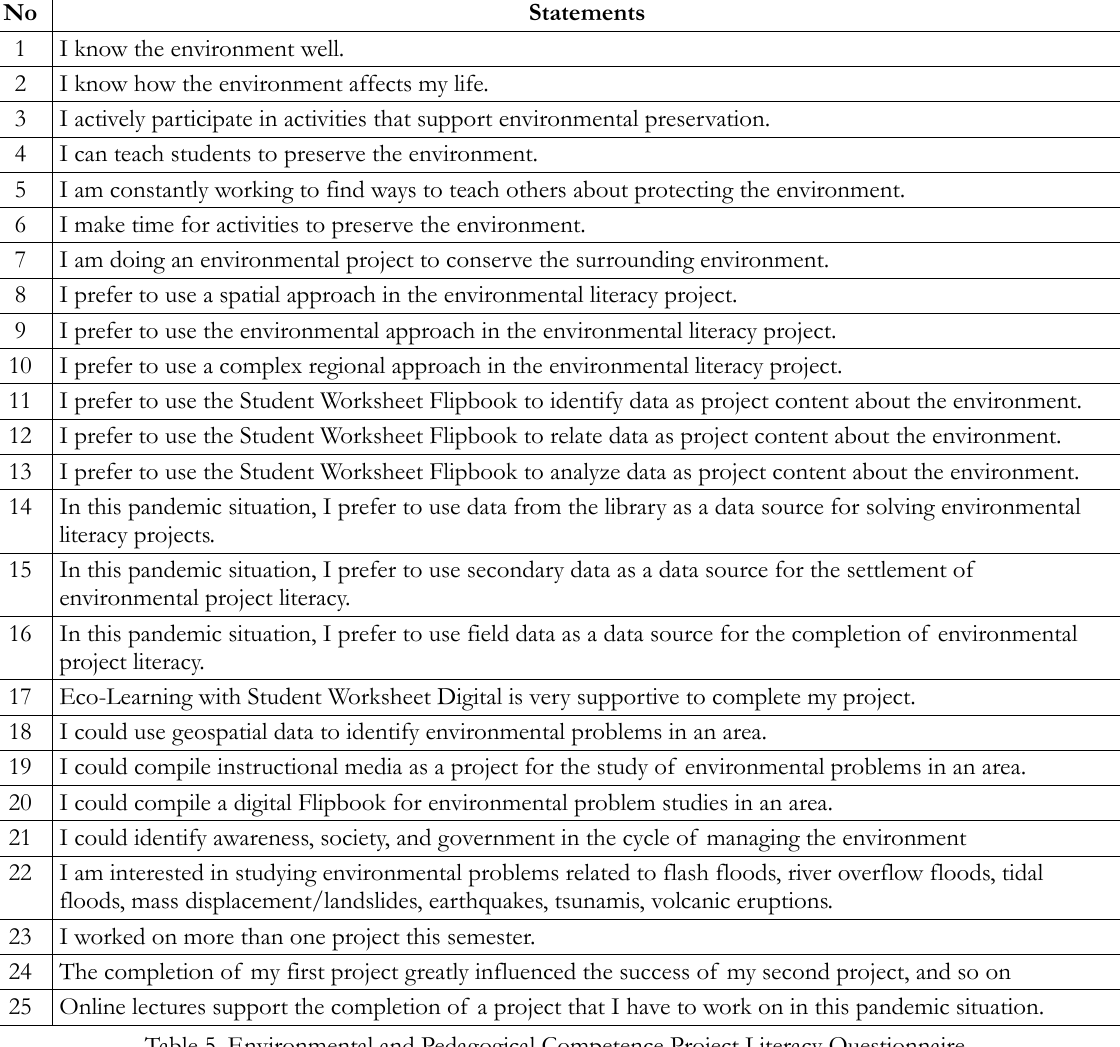
Table 5. Environmental and Pedagogical Competence Project Literacy